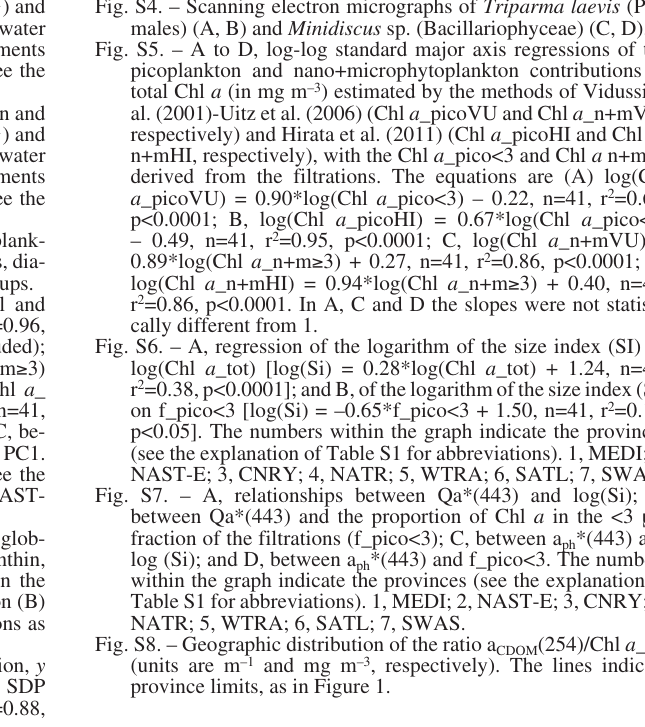
(254)/Chl a _tot CDOM